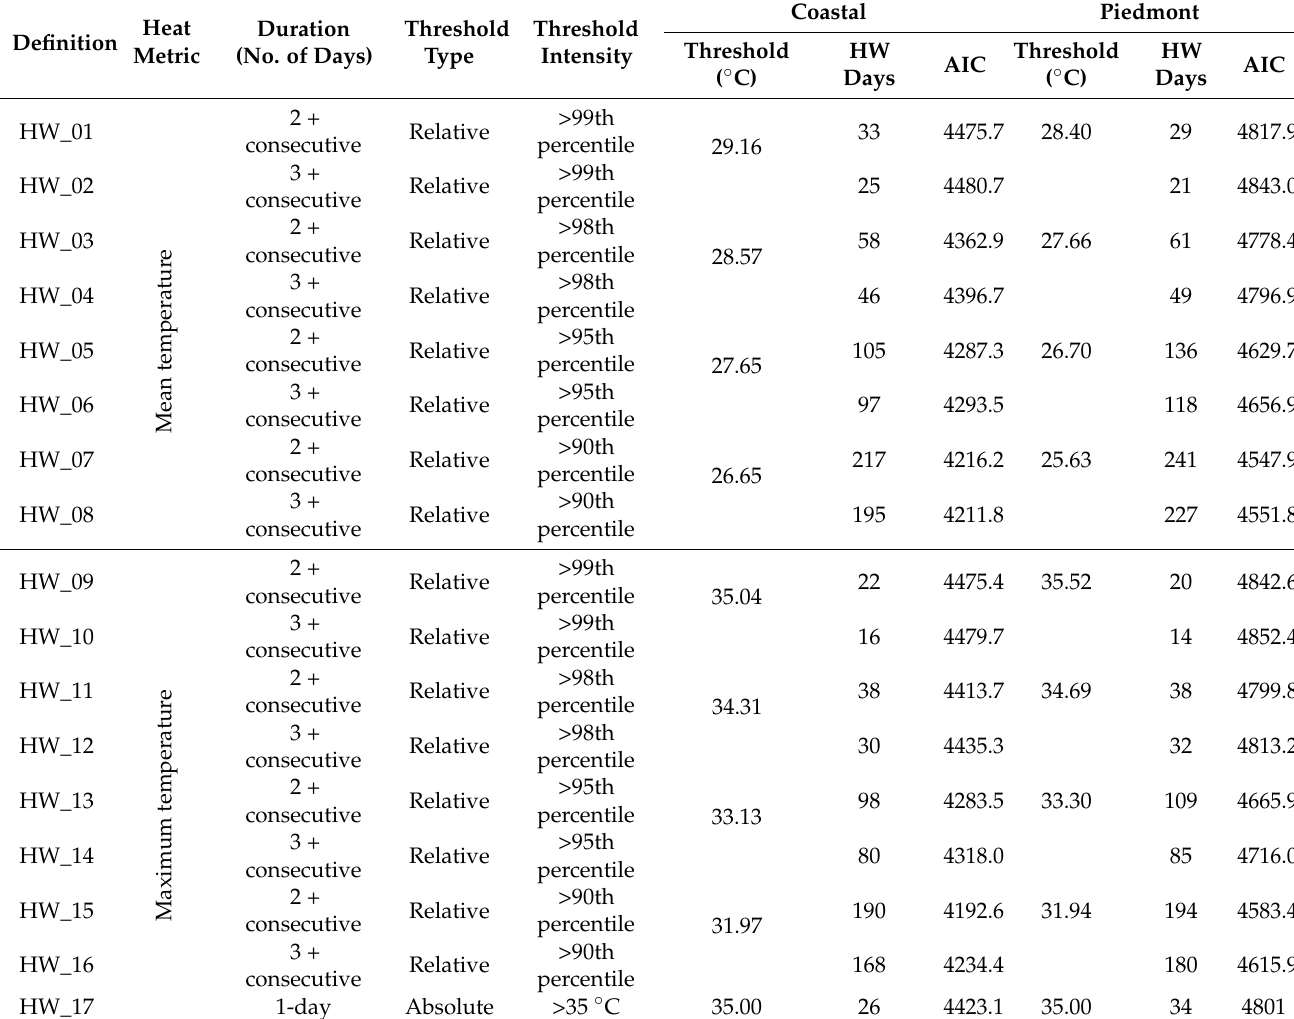
Table 1. Description of the heat wave